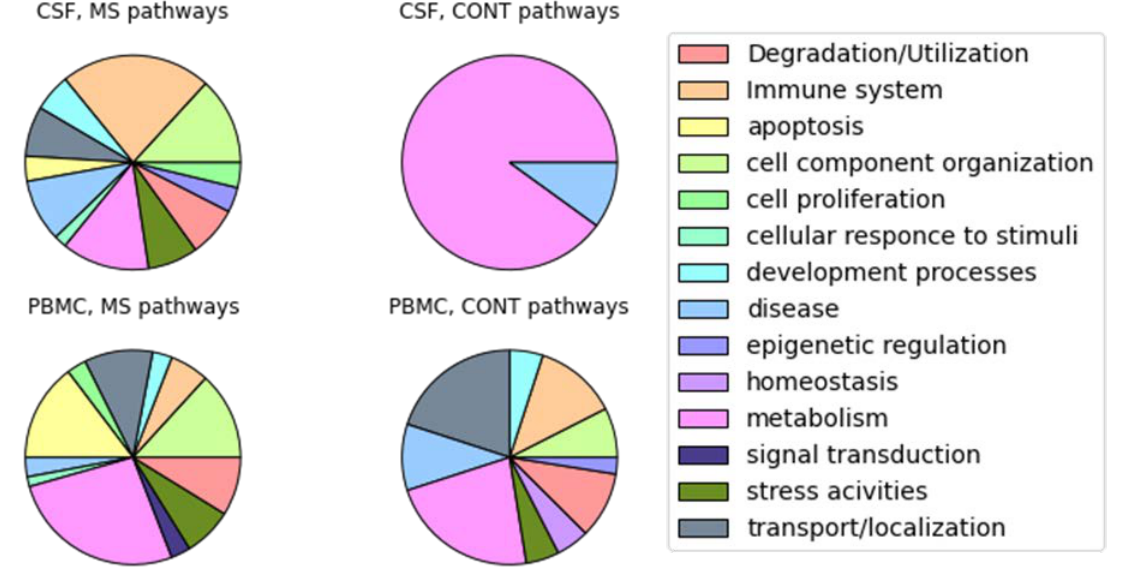
Figure 1. A summary of the unique pathway categories in MS state compared to control (CONT) detected for each cell type separately. For a better understanding of the overall picture of the processes, pathways are grouped into generalized categories.